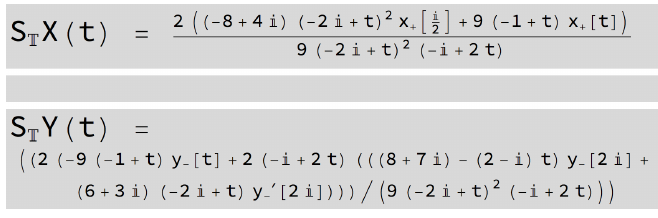
Figure 9. Output given by the [SInt] algorithm.